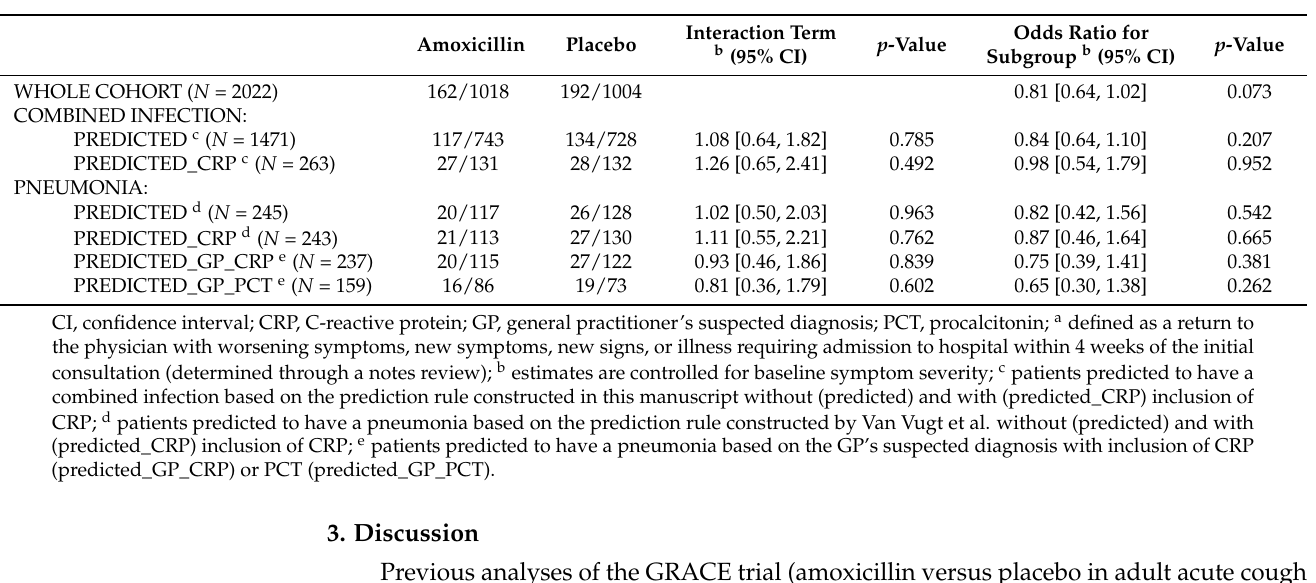
Table 4. Illness deterioration a in patients consulting in primary care with acute cough treated with amoxicillin versus